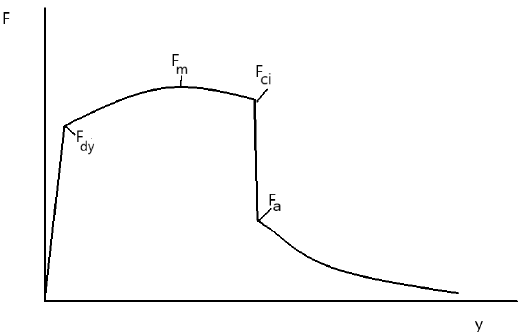
Figure 2. Schematic illustration of the characteristics of the force–displacement curve for an instru- mented Charpy-V tests freely after [18].